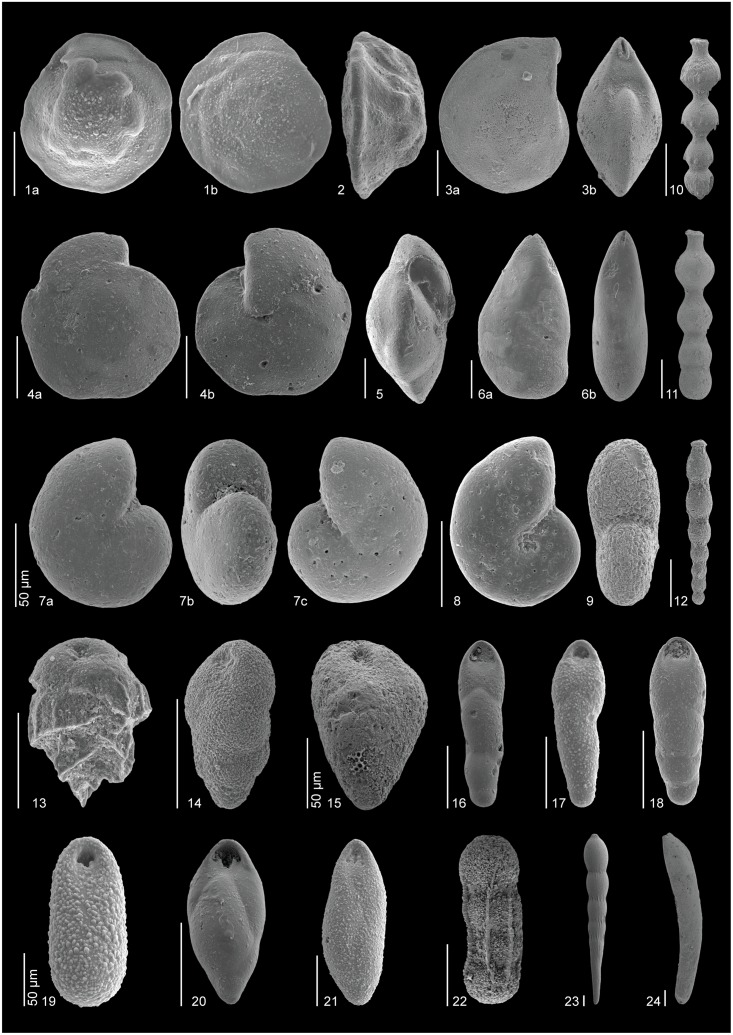
SEM images of some ubiquitous Ypresian (lower Eocene) species.All scale bars represent 100 μm, unless otherwise indicated. 1, Nuttallides truempyi (sample 865B-10-4, 120–125 cm): a) ventral, b) dorsal. 2, Nuttallides truempyi (sample 865B-10-5, 111–116 cm): apertural. 3, Lenticulina sp. (sample 865B-10-4, 120–125 cm): a) lateral, b) apertural. 4, Oridorsalis umbonatus (sample 865C-12-4, 6–8 cm): a) dorsal, b) ventral. 5, Oridorsalis umbonatus (sample 865C-12-4, 6–8 cm): apertural. 6, Astacolus sp. (sample 550-29-1, 8–10 cm): a) lateral, b) apertural. 7, Anomalinoides praespissiformis (sample 401-13-4, 130–132 cm): a) dorsal, b) apertural, c) ventral. 8, Anomalinoides ammonoides/spissiformis (sample 550-29-4, 145–147 cm): ventral. 9, Anomalinoides ammonoides/spissiformis (sample 550-29-1, 52–54 cm): apertural. 10–12, Stilostomellids: 10, Siphonodosaria lepidula (sample 550-29-5, 126 cm), 11, Siphonodosaria pomuligera (sample 401, 12-CC), 12, Strictocostella matanzana (sample 401-13-1, 91.5–92.5 cm). 13, Bulimina trinitatensis (sample 690-8A). 14, Bulimina simplex (sample 550-29-4, 65–67 cm). 15, Bulimina tuxpamensis (sample 1051-48-2, 135–137 cm). 16–21, Pleurostomellids: 16, Pleurostomella sp. 2 (sample 1258-14-4, 44–46 cm), 17, Pleurostomella sp. B (sample 865B-10-3, 4–6 cm), 18, Pleurostomella sp. 2 (sample 550-29-4, 35–37 cm), 19, Pleurostomella sp. D (sample 865B-10-3, 4–6 cm), 20, Pleurostomella acuta (sample 1258-14-4, 14–16 cm), 21, Pleurostomella sp. A (sample 865B-10-3, 60–62 cm). 22–24, Uniserial lagenids: 22, Chrysalogonium sp. 2 (sample 550-29-4, 95–97 cm), 23, Chrysalogonium ciperense (sample 550-29-4, 105–107 cm), 24, Dentalina sp. (sample 401-13-1, 84.5–85.5 cm).